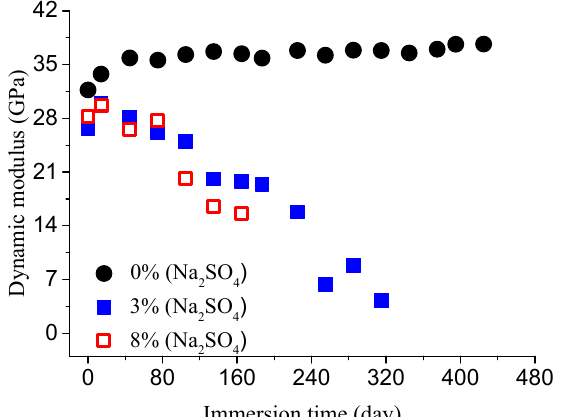
Figure 5. Dynamic modulus evolution of concrete specimens with the water ‐ to ‐ cement ratio of 0.4 in different concentrations of sodium sulfate solution.